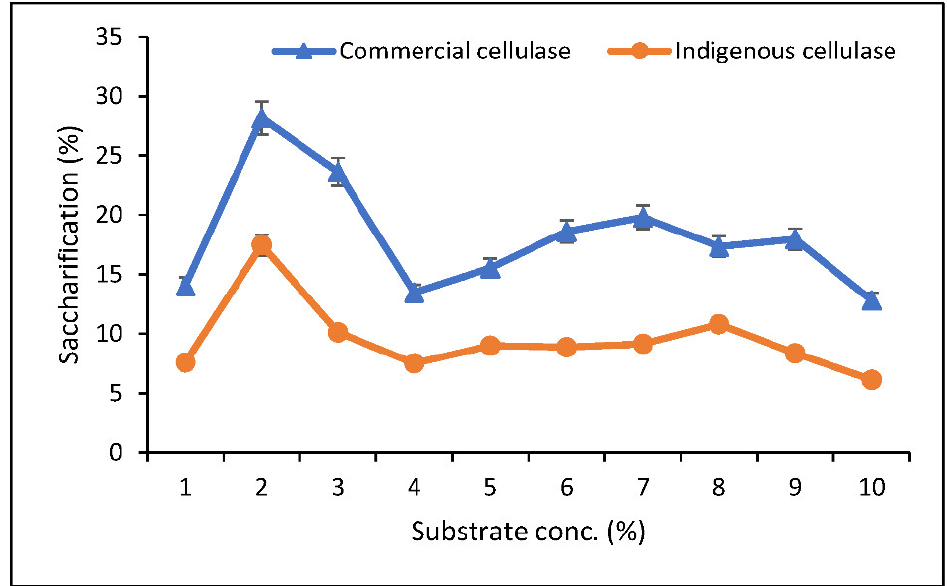
Figure 5. Optimization of time (h) for saccharification.